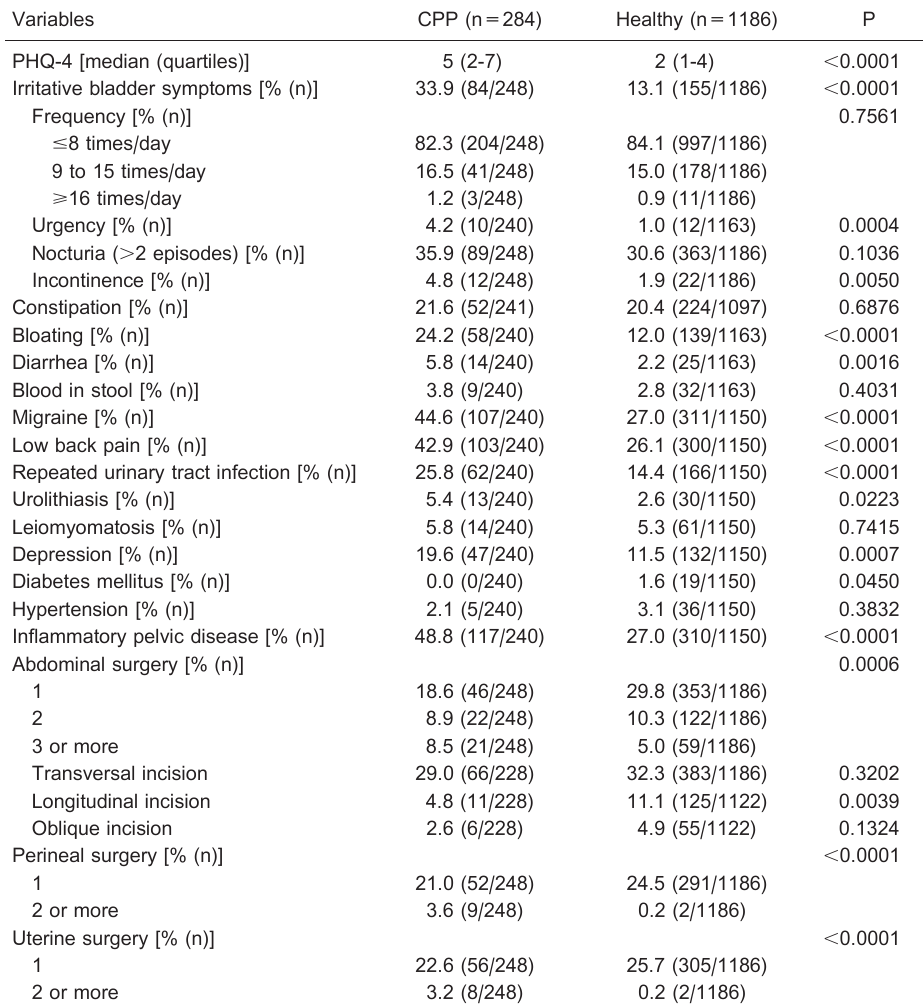
Table 3. Characteristics of clinical conditions and other antecedents of women with chronic pelvic pain (CPP) and healthy women.